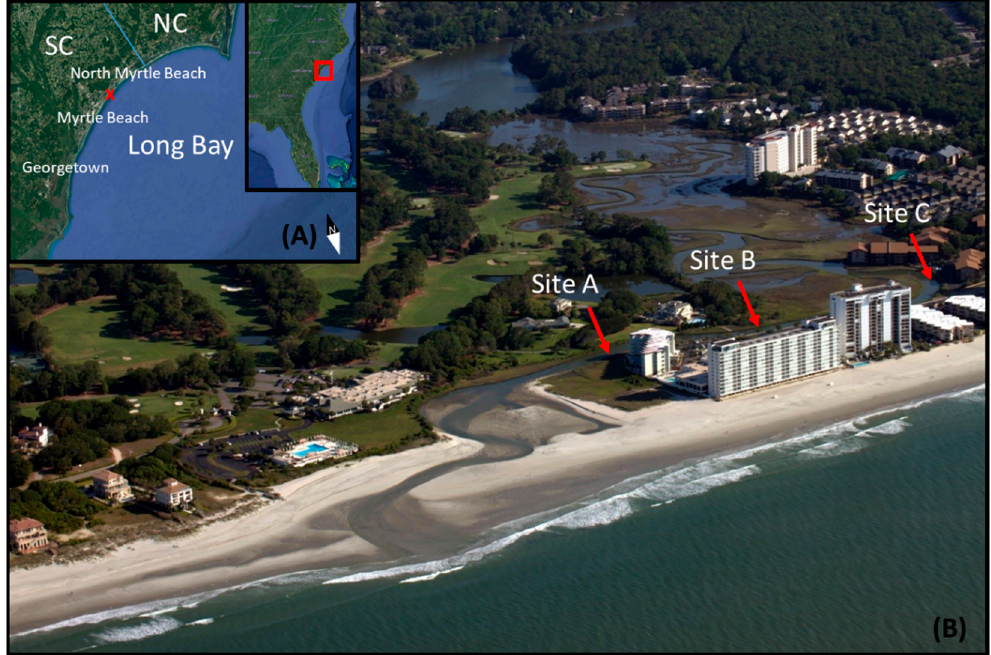
Figure 1. ( A ) satellite image of the southeastern United States with emphasis on the Long Bay area, located between North Carolina (NC) and South Carolina (SC). The location of the study area is approximated by the red “x” and the state border is defined by the light blue line; ( B ) aerial photo of Singleton Swash tidal creek showing the most dynamic area of the swash between the waterline and beach dune as well as the surrounding watershed. Measurement locations for this study are also labeled as Site A, Site B, and Site C.